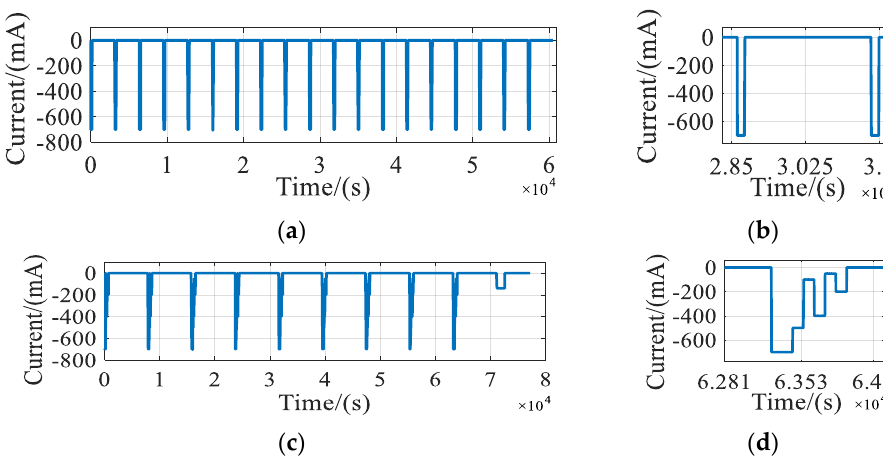
Figure 3. Schematic of the discharge current. ( a ) Incremental OCV test. ( b ) Partial zoom view of incremental OCV test. ( c ) Dynamic discharge test. ( d ) Partial zoom view of the dynamic discharge test.